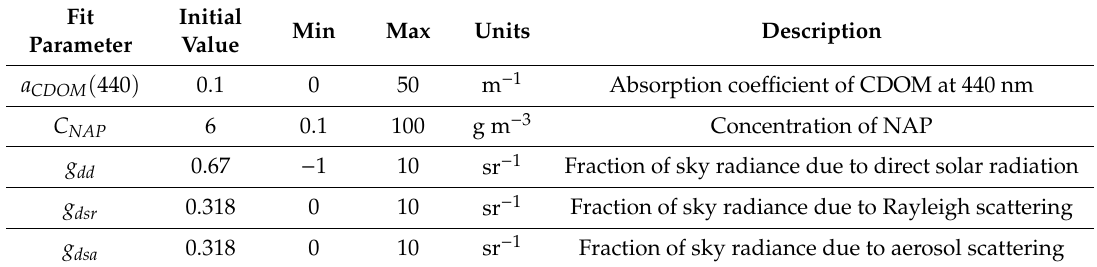
Table 2. Fit parameters of WASI for the deep-water